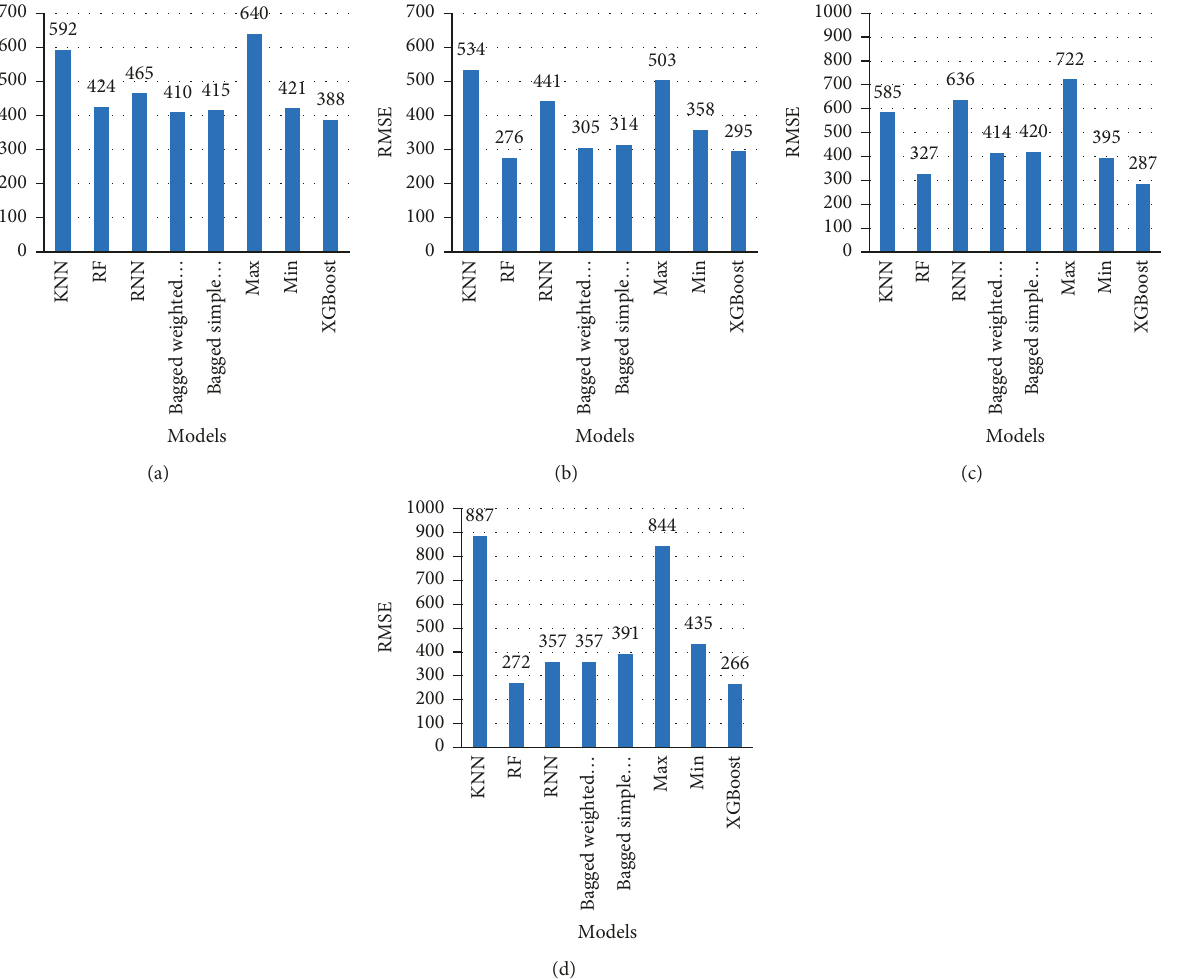
Figure 6: RMSE of base, bagging, and stacking models for the first quartiles of the observed traffic flow. (a) Mid-term models of Tehran to Saveh. (b) Mid-term models of Saveh to Tehran. (c) Short-term models of Tehran to Saveh. (d) Short-term models of Saveh to